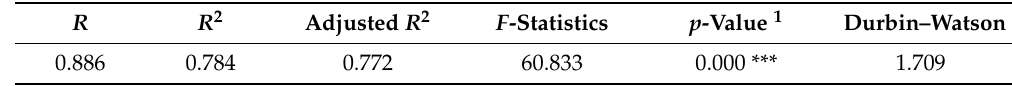
Table 7. Summary of Regression Model